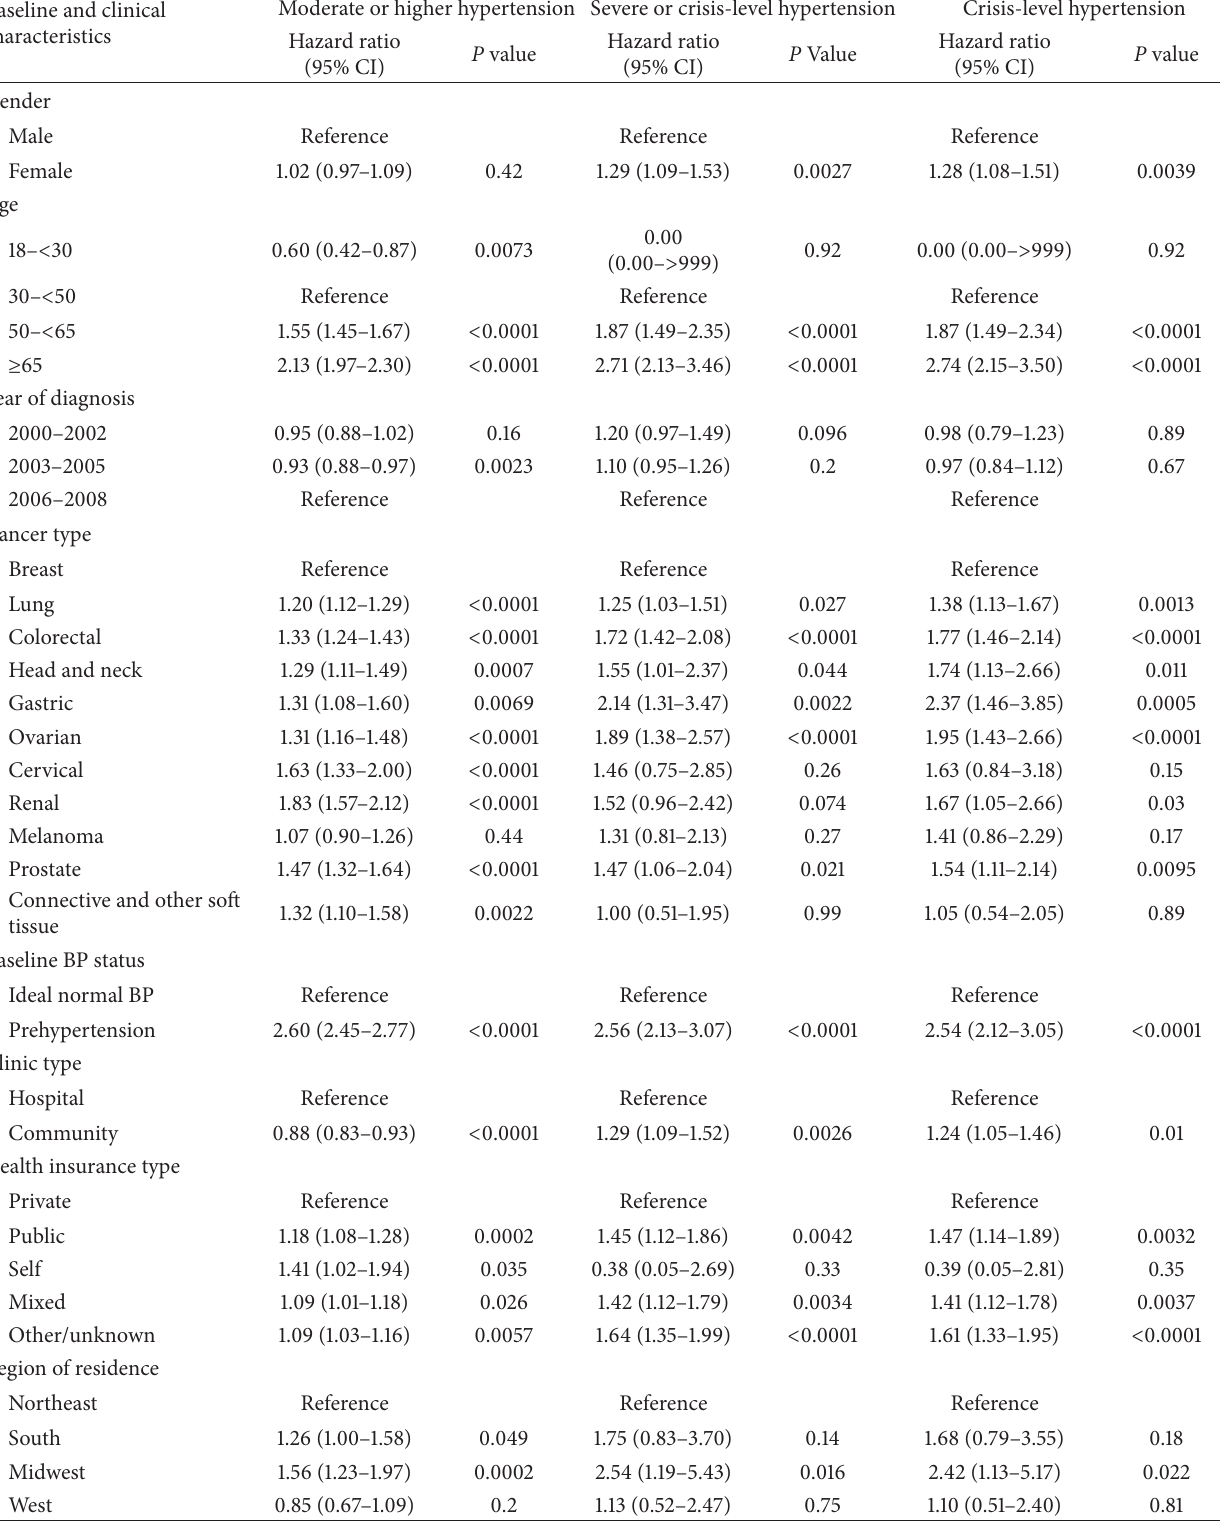
Table 5: Cox proportional hazards regression analysis identifying predictors of new-onset